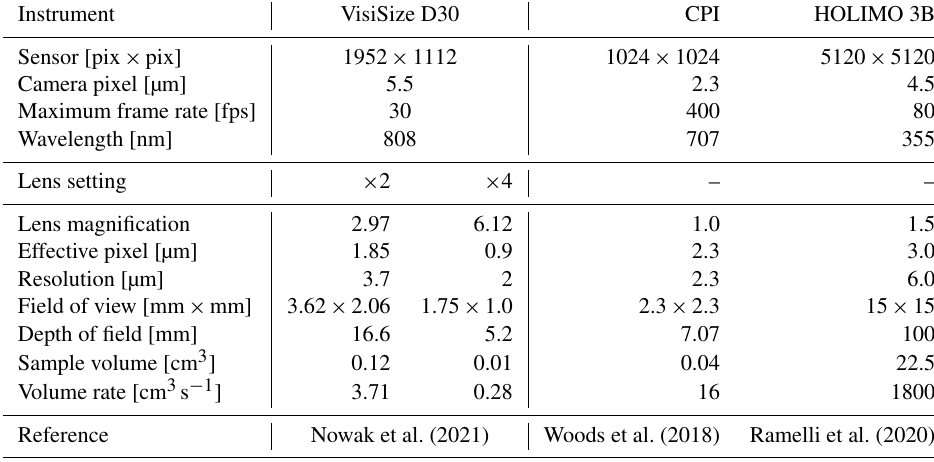
Table 1. Overview of the latest shadowgraphy and holography sizing systems for cloud droplets: the VisiSize D30, cloud particle imager (CPI), and HoloBalloon (HOLIMO 3B).